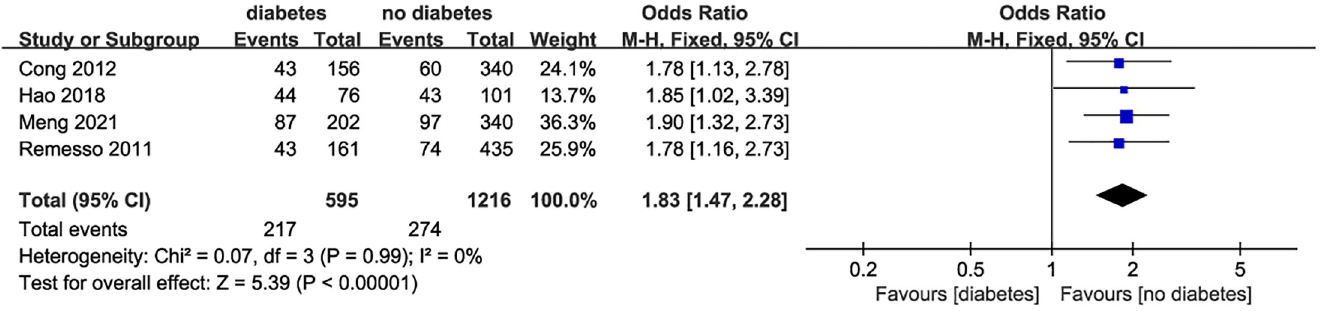
Fig 5. Forest plot for the relationship between diabetes and dysphagia after